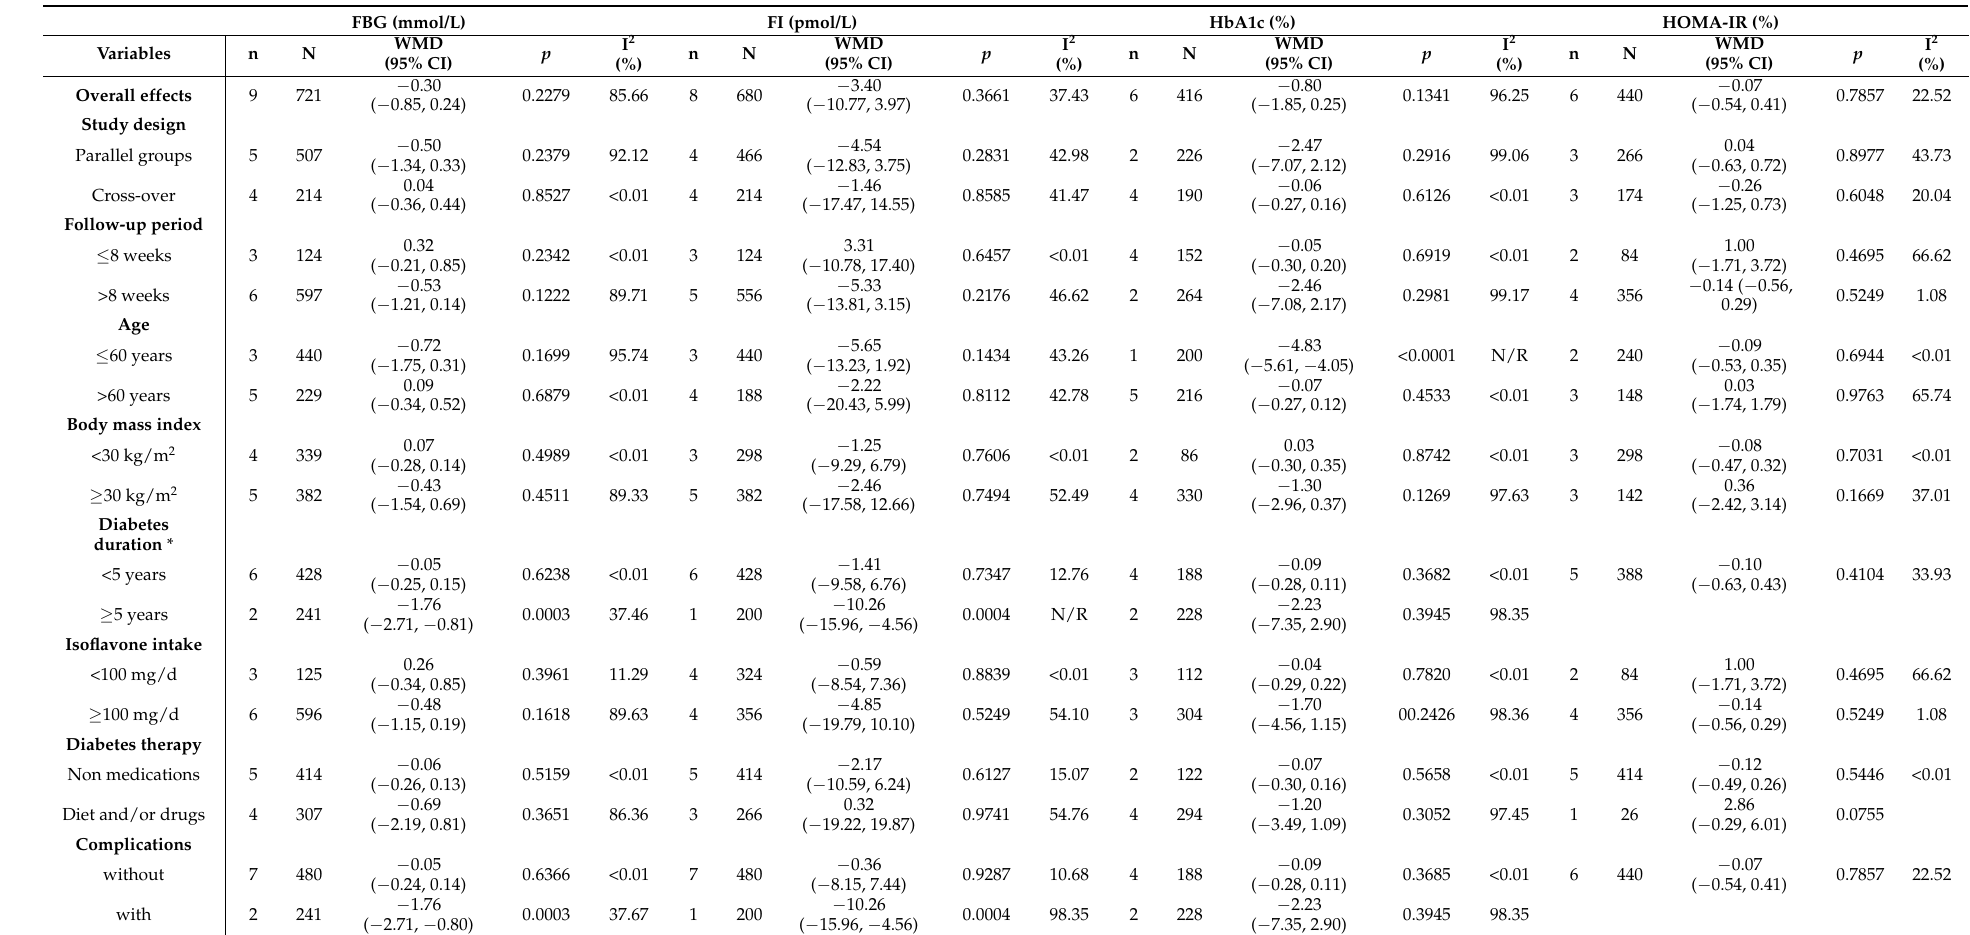
Table 2. Pooled estimates of treatment effect on glycemic control in subgroups of